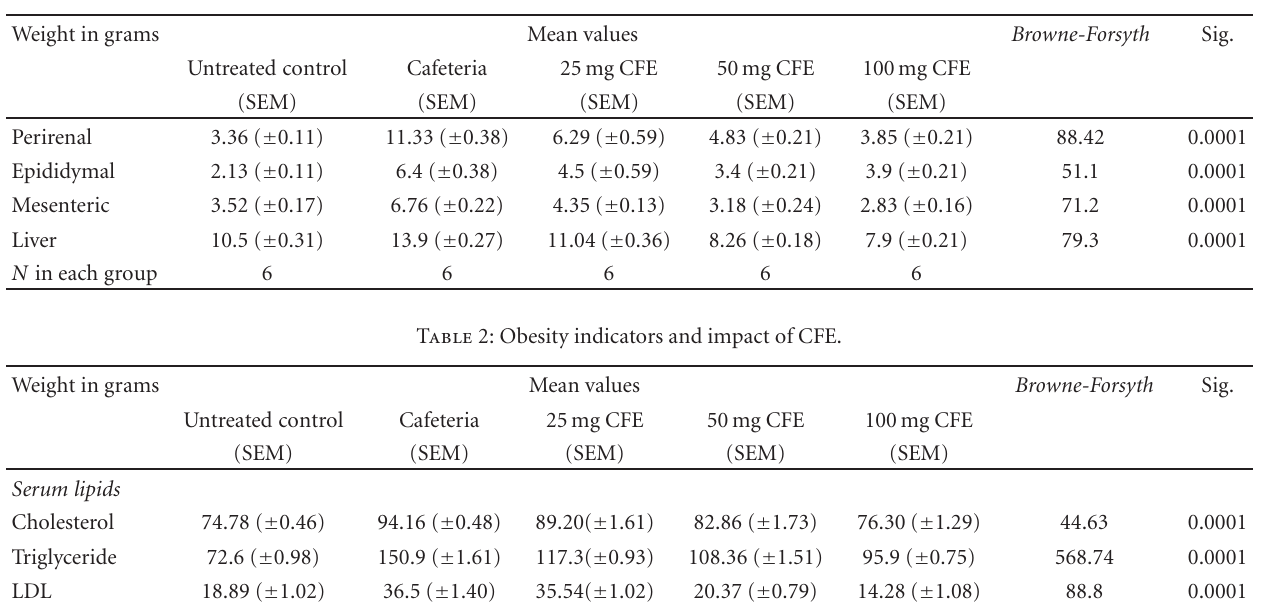
Table 1: Morphometric analyses of fat pads and liver weight.